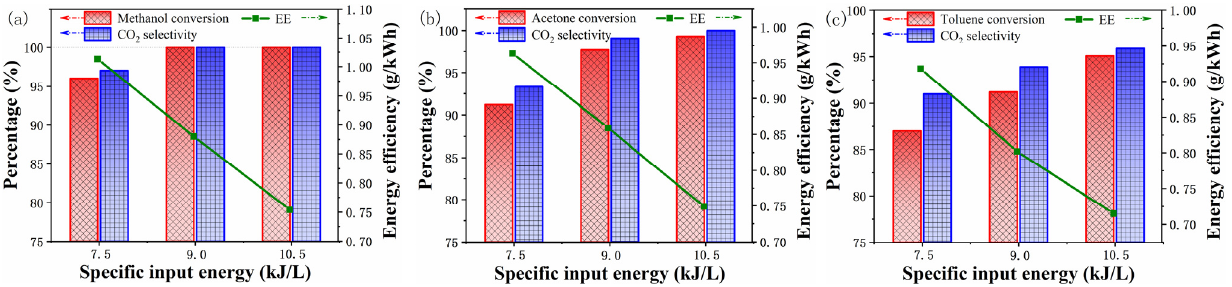
Figure 3. Influence of SIE on degradation indexes of ( a ) methanol ( b ) acetone, and ( c ) toluene by Mn/ZSM ‐ 5 ‐ N catalyst.